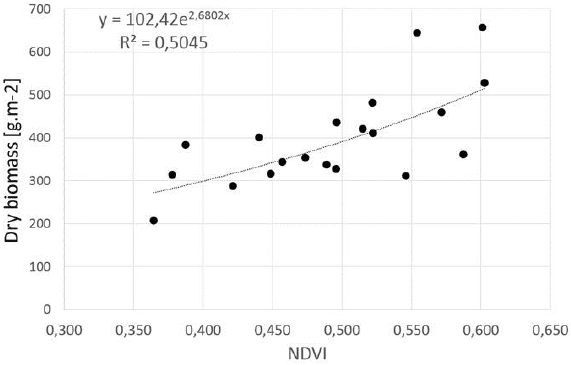
Figure 4. Scatter plot of NDVI values and dry biomass from UAV image in BBCH 32